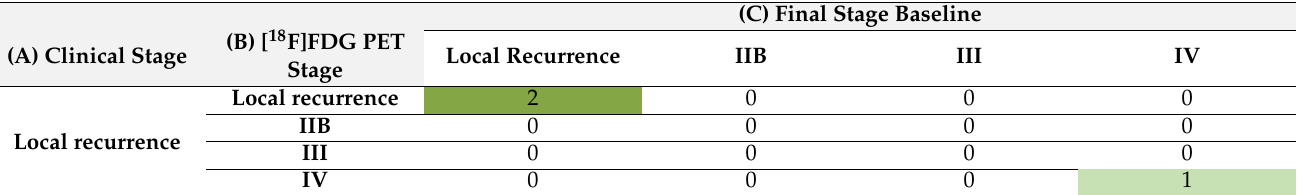
Table 2. FDG PET staged 16/70 patients incorrectly compared to final baseline stage. Patients who received FDG PET imaging prior to surgery or who did not receive surgical treatment are included ( n = 70). The table indicates the number of patients with their corresponding stage. (A) Staging based on clinical assessment, pathology and conventional imaging performed at baseline. (B) Staging based on FDG PET imaging. (C) Final stage determined after FDG PET imaging, additional imaging and/or biopsy/cytology of new identified suspect